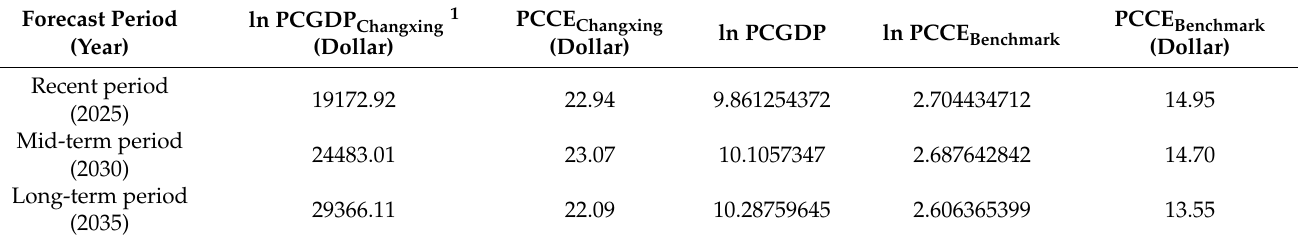
Table 5. Calculation results of PCCE benchmark in Changxing